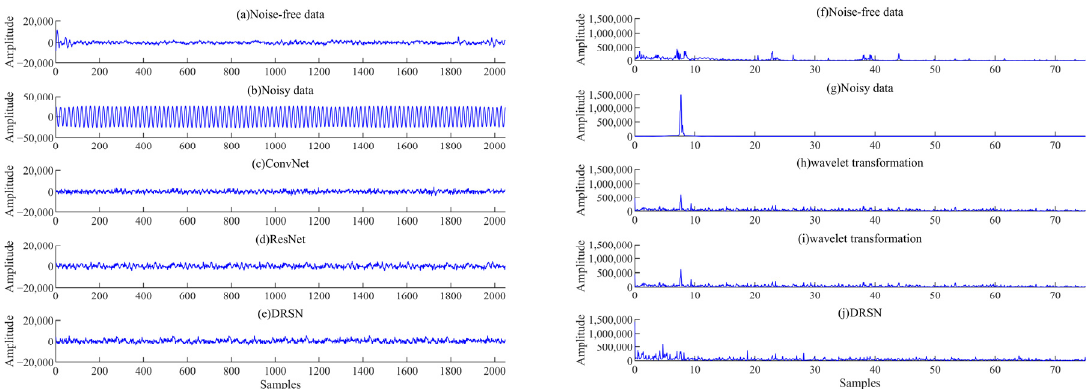
Figure 12. Denoising results for the data with harmonic noise. Time domain waveform ( a ) Noise-free data, ( b ) Noisy data, ( c ) the results of ConvNet, ( d ) the results of ResNet, and ( e ) the results of DRSN. Spectrum of ( f ) Noise-free data, ( g ) Noisy data, ( h ) the results of ConvNet, ( i ) the results of ResNet, and ( j ) the results of DRSN.